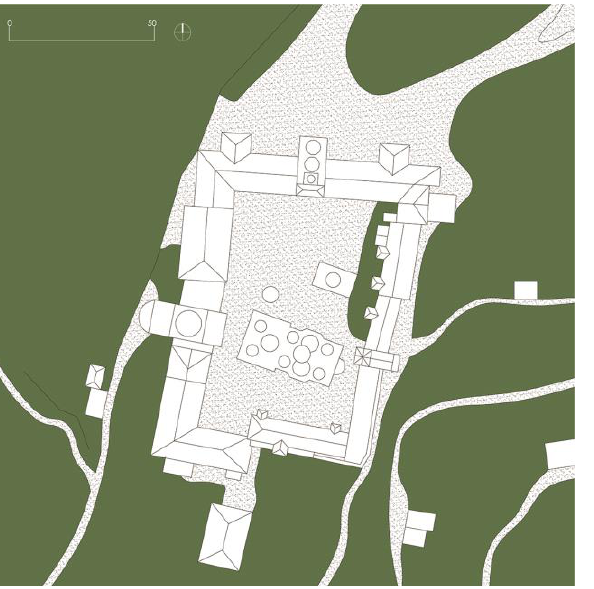
Figure 15 . The Monastery of Dochiariou. General plan.